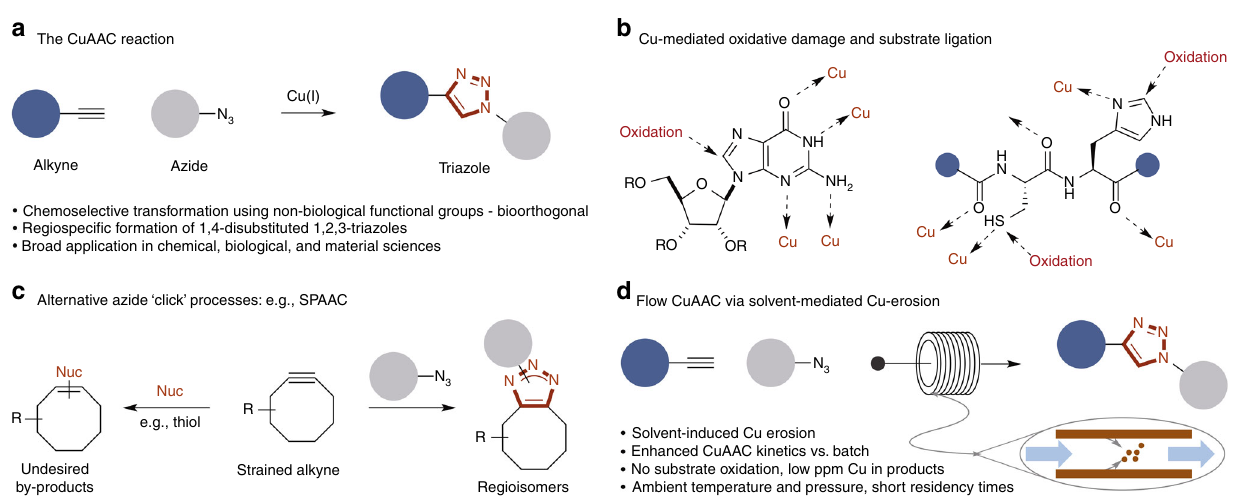
Fig. 1 Azide-alkyne cycloaddition strategies. a The archetypical CuAAC reaction; b Examples of oxidatively labile and ligating functional groups found in biomolecules; c The SPAAC reaction and and the formation of regioisomeric triazole products; d The fl ow-assisted CuAAC reaction (this work). CuAAC Cu-catalyzed azide-alkyne cycloaddition, Nuc nucleophile, SPAAC strain-promoted azide-alkyne